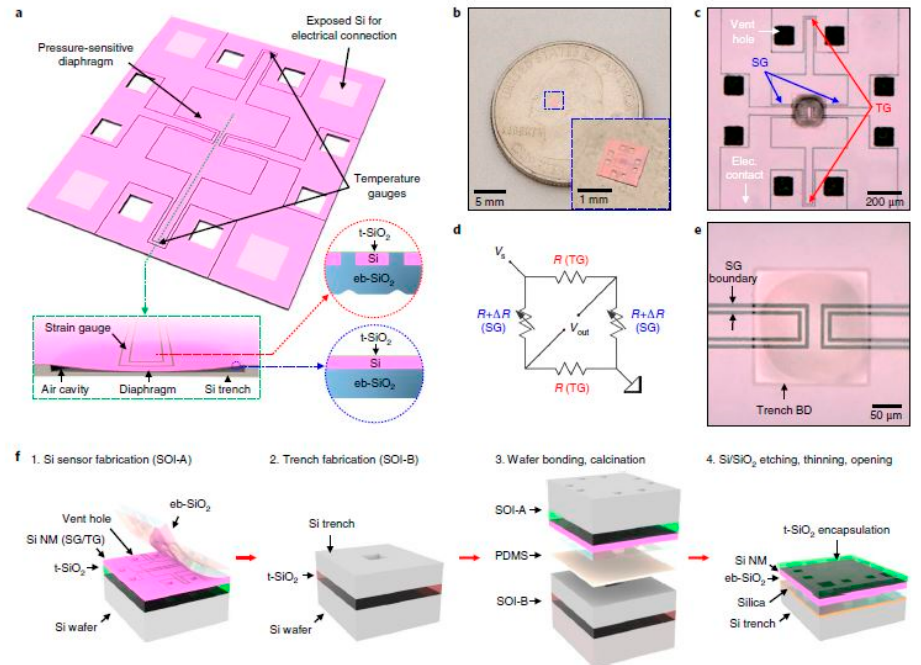
Figure 5. Schematic diagram of the fabrication process of the bioresorbable pressure sensors. The sensors were developed with monocrystalline silicon and silicon dioxide layers using thermal oxidation and electron-beam techniques. Two boundary lines were used to separate the strain gauges from the surrounding silicon. The system consisted of piezoresistive sensors, a voltage source and a meter to compensate for the variation of the temperature caused by the variation in the resistance with the pressure [95]. The image has been reproduced with permission from [95].